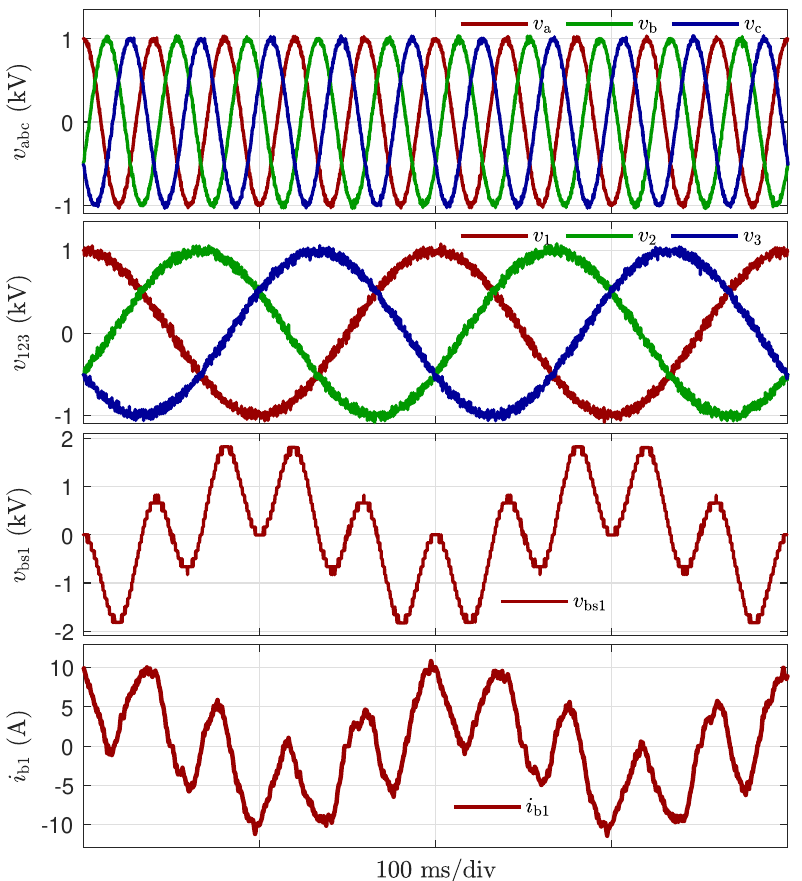
Figure 11. NLC: AC three–phase voltages v abc , v 123 , branch voltage v bs1 , and branch current i b1 .